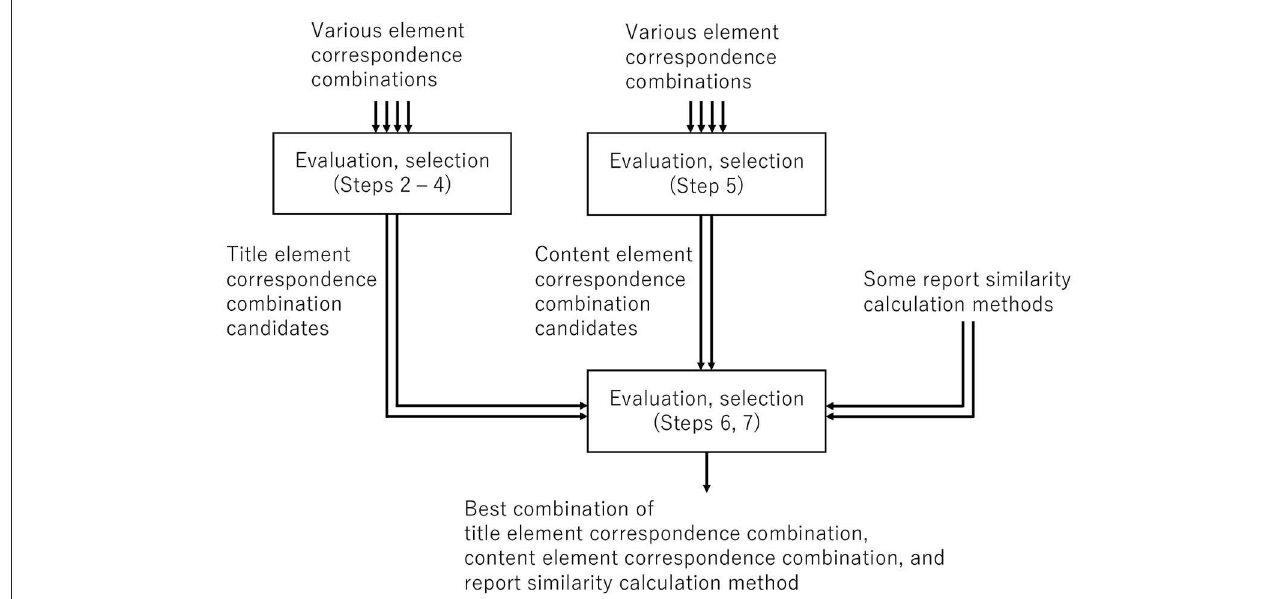
FIGURE8 Determination of element correspondences for training models and the report similarity calculation method.